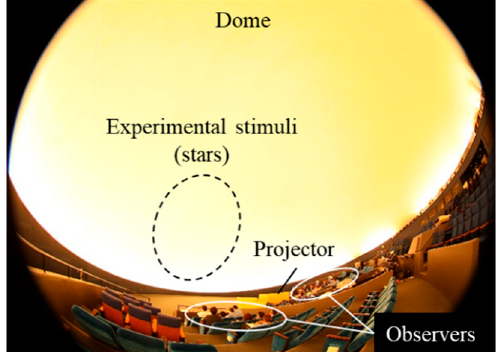
Figure 3. Snapshot of experimental environment. Table 2. Number of observers for each age.